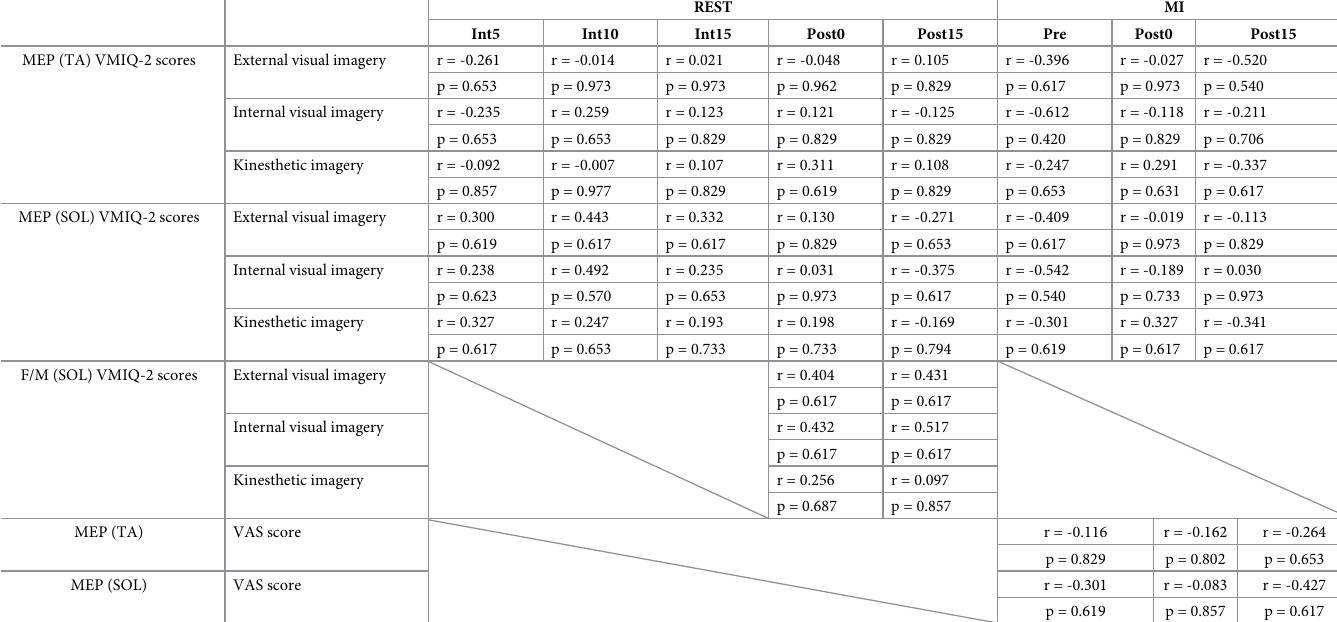
Table 7. Spearman correlation coefficients (r) and FDR-corrected p-values (p) between changes in MEP and VMIQ-2 scores, F/M and VMIQ-2 scores (external visual imagery, internal visual imagery, and kinesthetic imagery), and MEP and VAS scores.